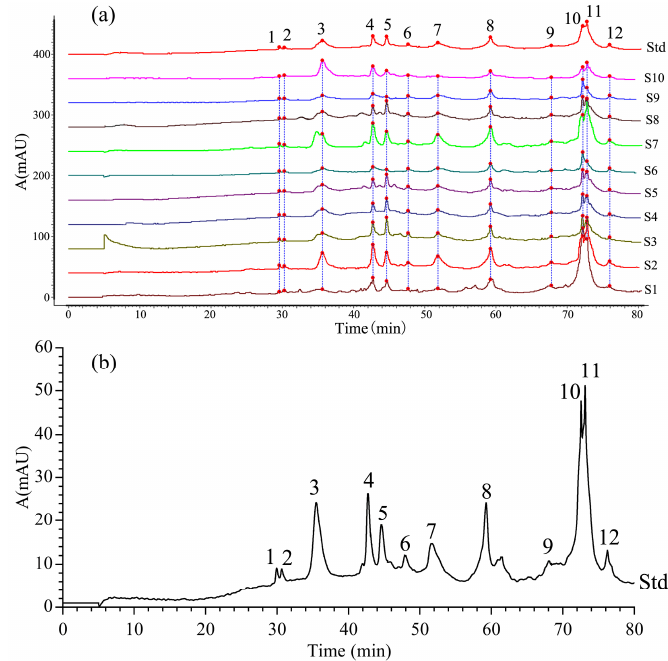
Figure 3. ( a ) HPLC fingerprint chromatographic spectra of 10 batches of Ranae Oviductus proteins. ( b ) The reference protein chromatographic spectra of Ranae Oviductus .